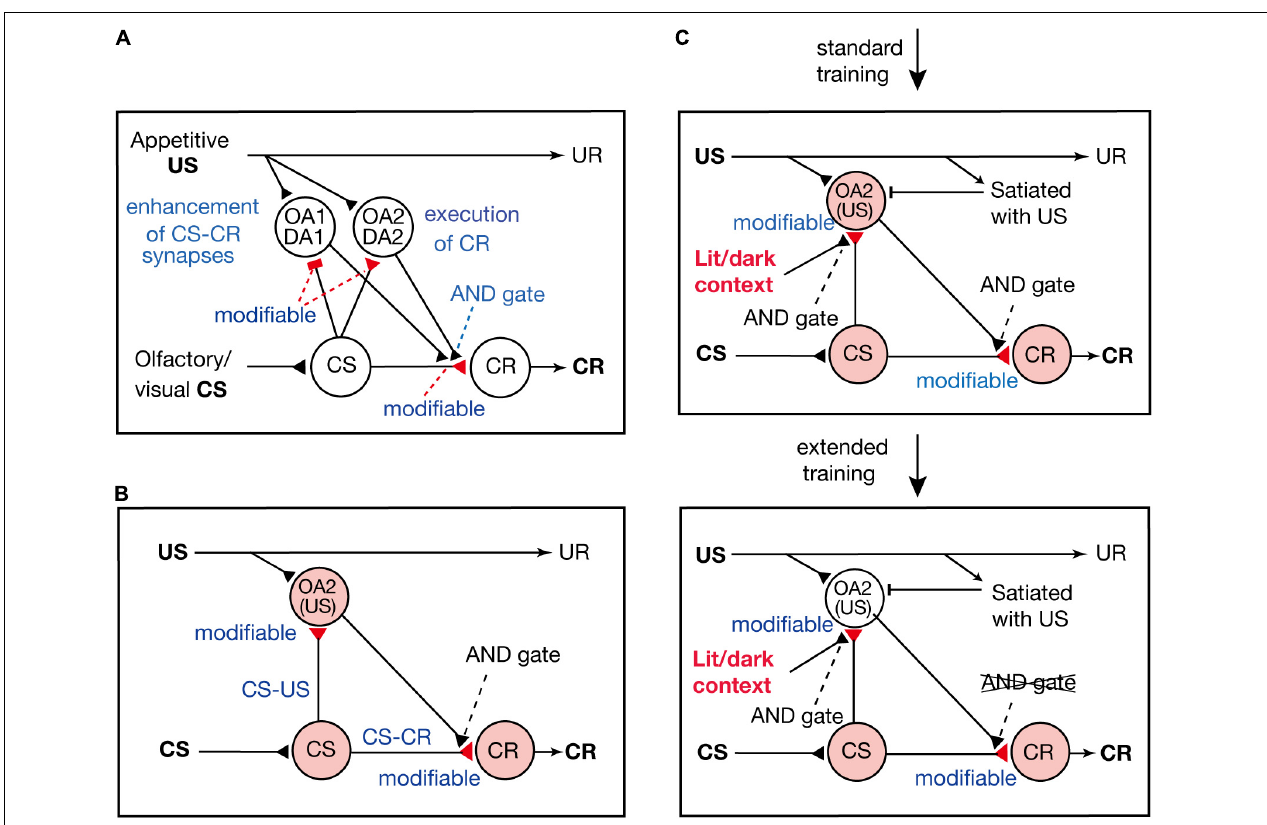
FIGURE 3 | Models of appetitive Pavlovian conditioning in crickets that account for the change from a US value-sensitive CR to a habitual one with extension of training. (A) A model of Pavlovian conditioning (Terao et al., 2015) that consists of four types of neurons: “CS” neurons that code the CS, two classes of OA or DA neurons (“OA1/DA1” neurons and “OA2/DA2” neurons) that code appetitive/aversive US, and “CR” neurons that produce the CR. The “OA1/DA1” neurons or “OA2/DA2” neurons receive inhibitory or excitatory synapses from “CS” neurons, the efficacy of which is strengthened by pairing of the CS and the US and by resulting simultaneous activation of their pre- and postsynaptic neurons (assuming Hebbian plasticity). The efficacy of excitatory synapses from “CS” neurons to “CR” neurons is strengthened when “CS” neurons and “OA1/DA1” neurons are activated at the same time (assuming Kandelian plasticity, Kandel, 2001), and “CR” neurons are activated when “CS” neurons and “OA2/DA2” neurons are activated at the same time (shown as AND gate). (B) A part of the model is shown for highlighting the roles of “OA2” neurons for execution of appetitive CR. (C) In this model, we revised our previous model in (B) to account for the finding that the CR is sensitive to US devaluation after standard training but not after extended training (Mizunami et al., 2019) and that the CR is initially specific to the condition of illumination under which the cricket received training, but the specificity is lost after extended training (Sato et al., 2021). We assume that activation of “OA2” neurons does not occur when the animal is satiated with the US or when the test is performed outside the context of training. Hence, a CR does not occur after US devaluation or outside the context of training after standard training. We also assume that the efficacy of “CS-CR” synapses is further enhanced by